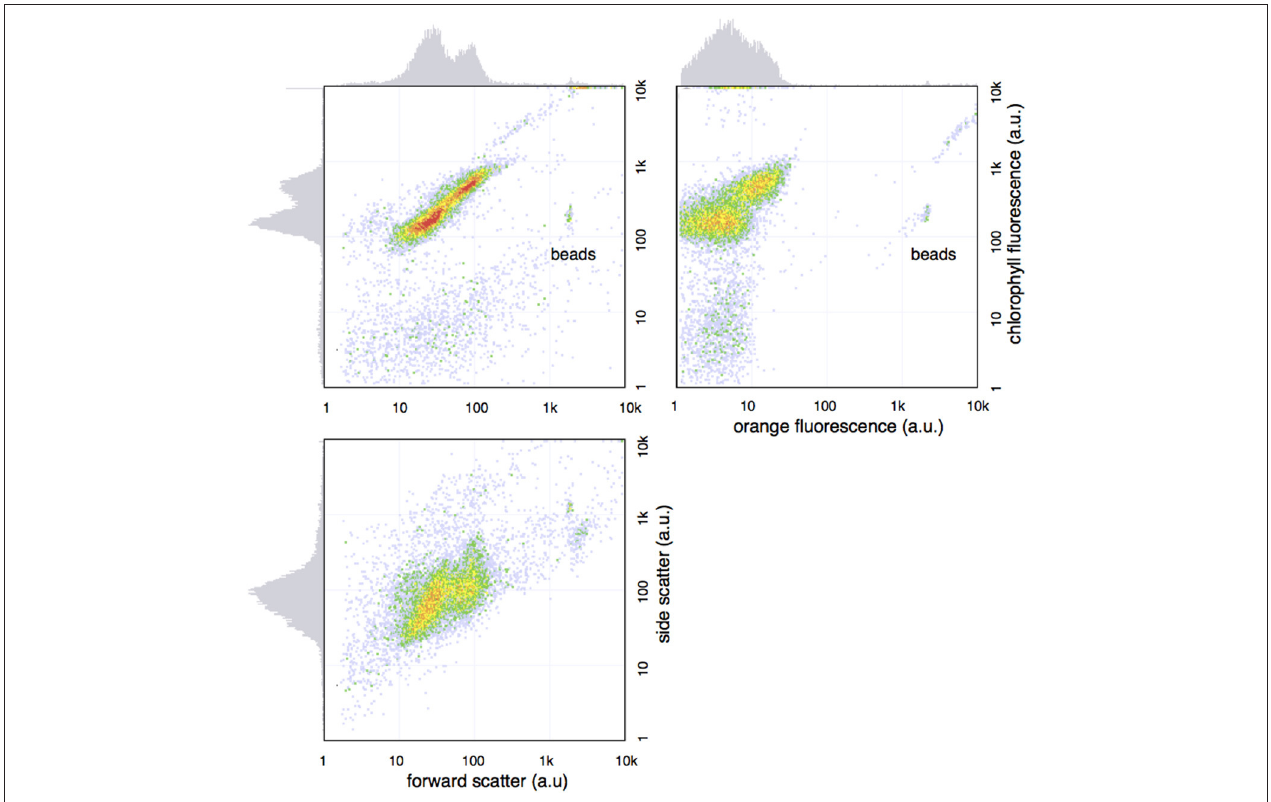
FIGURE 2 | Bimodal distribution of Prochlorococcus seen in the sample from 90m in the cast of Figure 1 . The bivariate plot show two populations with distinct FCM phenotype, as seen by light scatter and fluorescence profiles on the x- and